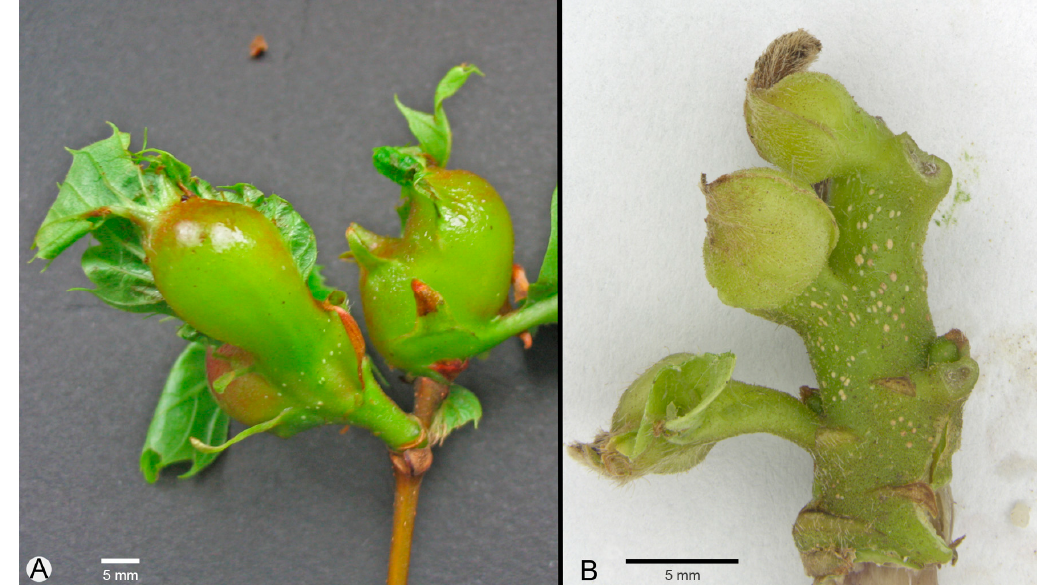
Figure 6. Stem galls collected on ( A ) susceptible and ( B ) red salernitan ecotype (RSE) tree.